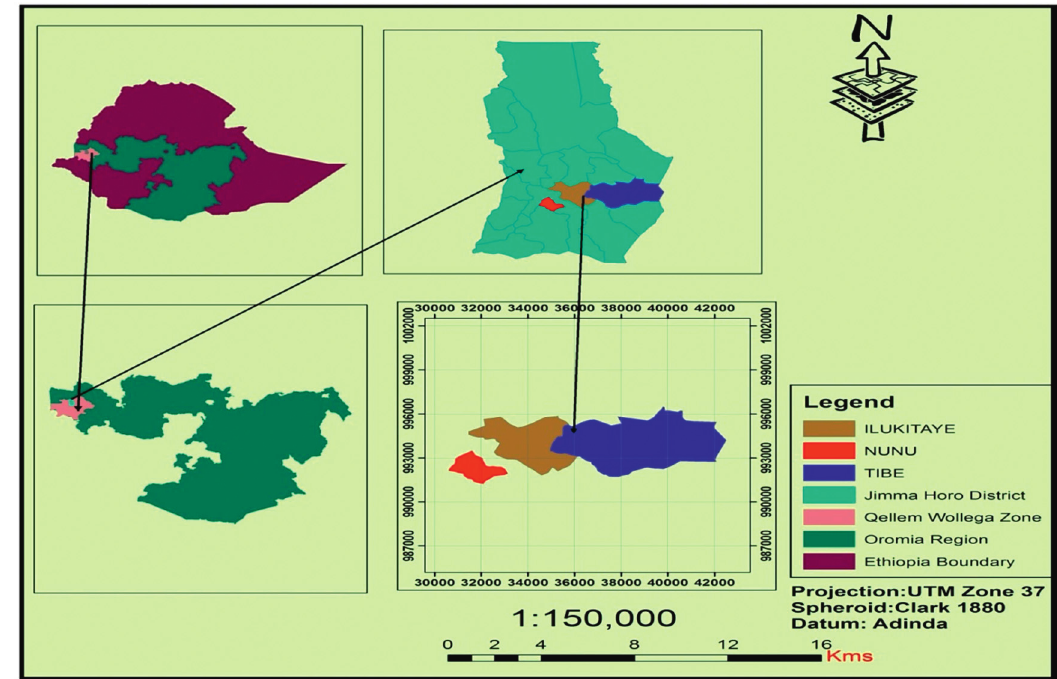
Figure 2: Map of study area (survey